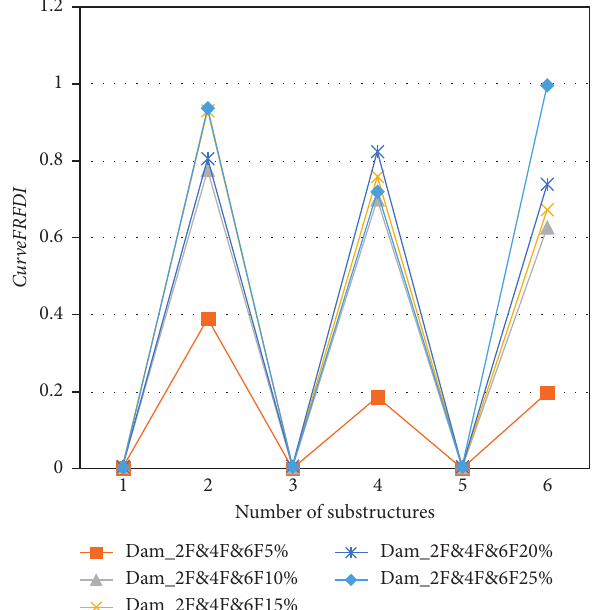
Figure 21: The comparison of the CurveFRFDI for 5%, 10%, 15%, 20%, and 25% stiffness reduction in the 2 nd , the 4 th , and the 6 th floors.